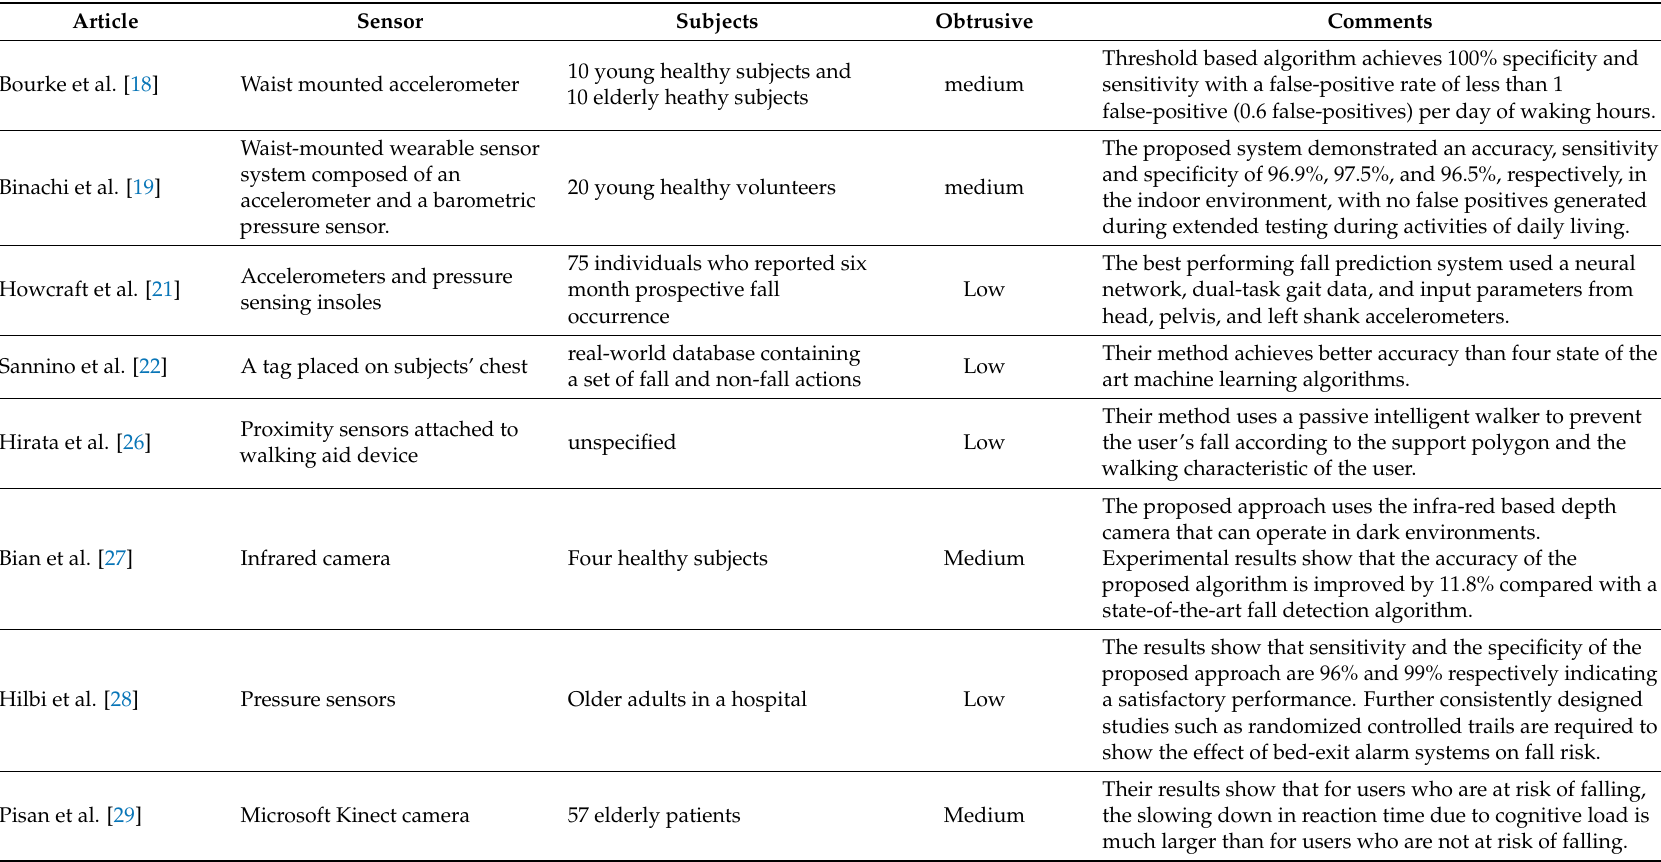
Table 1. Qualitative comparison of various fall detection and prediction